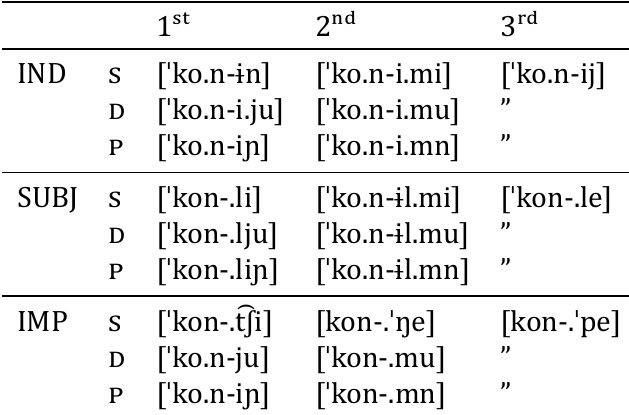
(11) Stress in further in(cid:976)lected verbs, following Valdivia